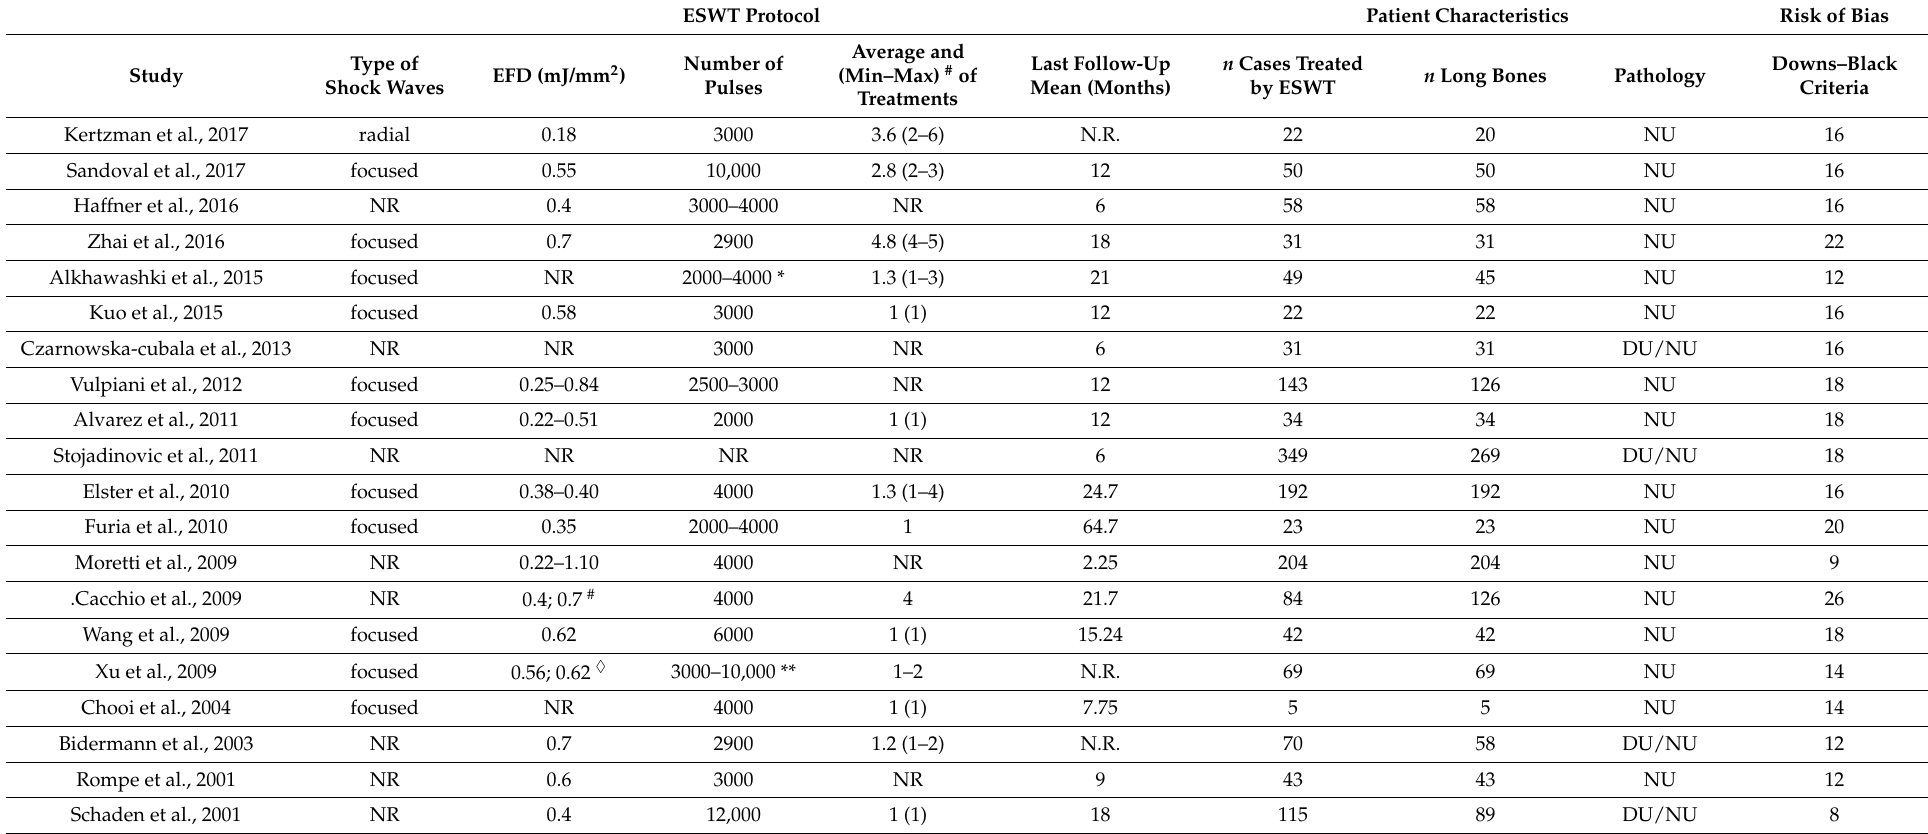
Table 1. ESWT protocol, patient characteristics, and risk of bias of included studies. EFD = energy flux density, NR = not reported, NU = nonunion, DU = delayed union, * 3000–4000 pulses applied to femur, tibia, fibula, humerus; 2000–3000 pulses applied to other, smaller bones, ** 6000–10,000 pulses applied to femur and tibia; 4000 pulses applied to humerus; 3000 pulses applied to radius and ulna, 6000 pulses applied to femur and tibia; 3000 pulses applied to humerus; 2000 pulses ♦ applied to radius and ulna; 1000 pulses applied to MT, # 0.4 (group 1)–0.7 (group 2), ◊ 0.56 for humerus, radius, ulna; 0.62 for femur and tibia; ⌘ 0.47 for MT; 0.56 for humerus, radius, ulna; 0.62 for femur and